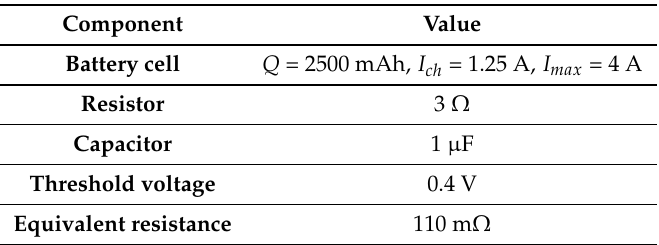
Table 4. Value of the components used in the